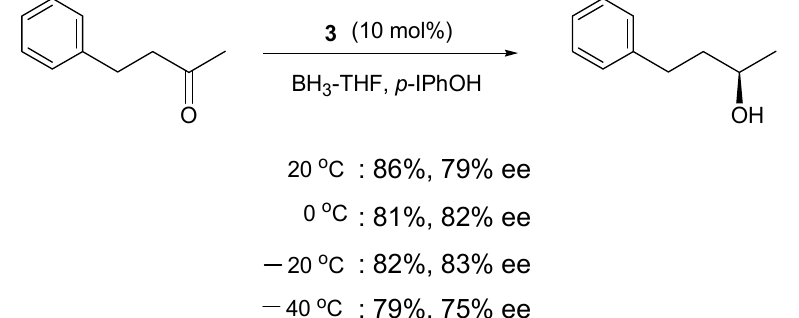
Scheme 5. Effect of temperature on enantioselectivity for the reduction of benzylacetone using 3 and p -iodophenoxyborane. All reactions were carried out with 10 mol% of 3 and 1.2 equiv of BH 3 and p -iodophenol in THF at room temperature.